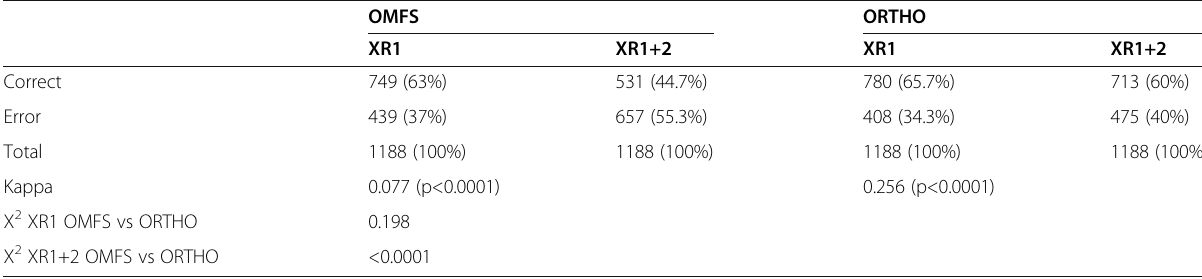
Table 3 Frequency and difference (X 2 ) of the responses indicated by oralmaxillofacial surgeons (OMFS) and orthodontists (ORTHO) when evaluating spontaneously erupted lower third molars (n=44) after analysis of one (XR1) or two serial radiographs (XR1 + 2)